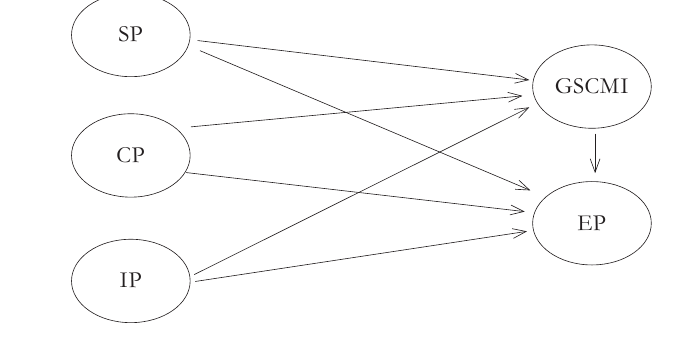
Fig. 1 – A proposed research model. Source: own